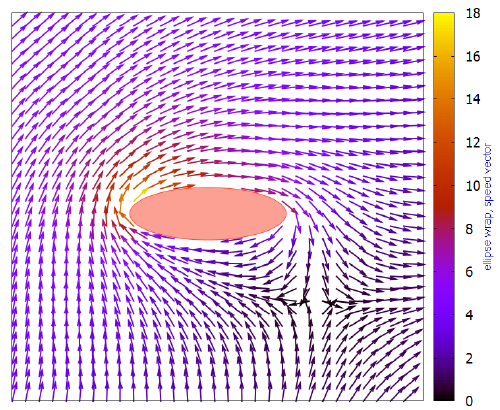
Fig. 10. The velocity field in the circulation flow around an elliptical cylinder.